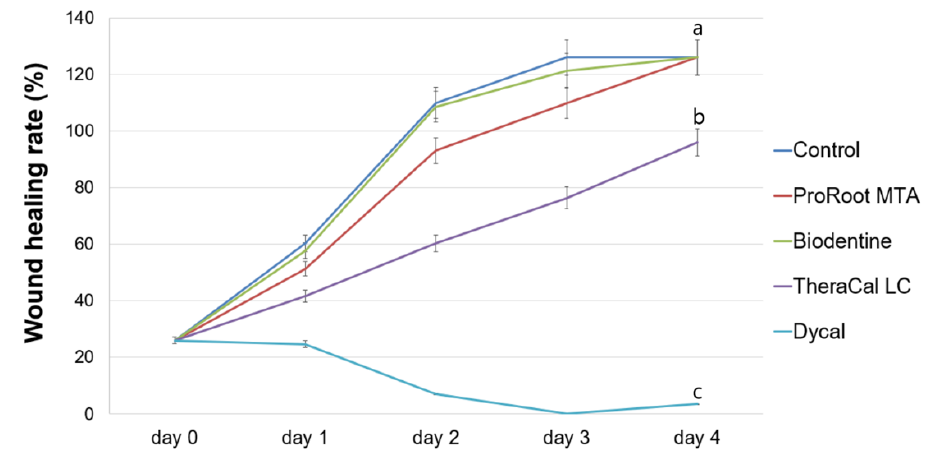
Figure 2. Evaluation of cell migration by wound healing assay. Di ff erent letters represent statistically significant di ff erences among experimental